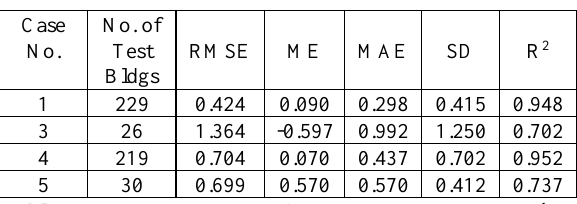
Table 3. Descriptive Statistics for Mean Height Extraction (Per Case).